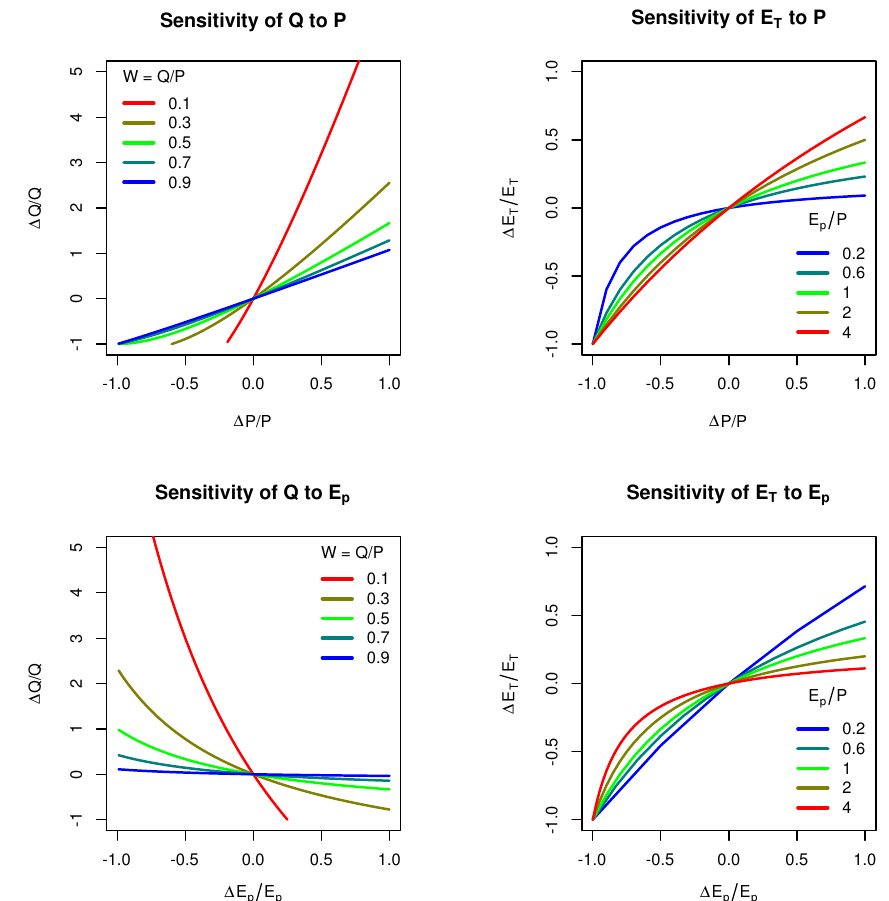
Fig. 4. Relative change in response to relative changes in P (top panels) and in E p (bottom panels) of Q (left panels) and E T (right panels) as predicted by the CCUW hypothesis. Changes in Q are dependent on runoff ratio W and on aridity E p /P and are coloured with respect to the respective runoff ratio and shown for an aridity index of E p /P =1. Relative changes in E T are dependent on aridity only and lines are coloured with respect to different aridity indices. Note that changes of 1Q/Q smaller than − 1 are not